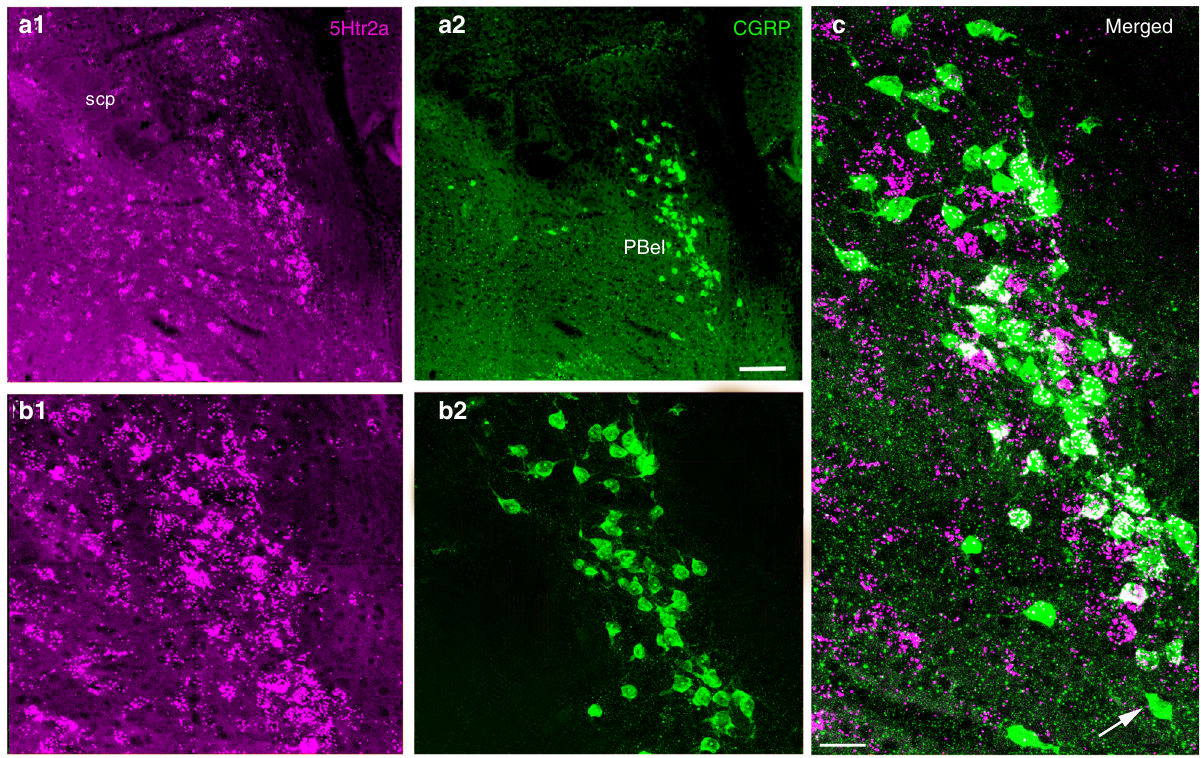
Fig. 7 Expression of 5HT 2a receptors mRNA (5Htr2a) by PBel CGRP neurons. Immuno fl uorescence photomicrographs of a brain section through the parabrachial area from a CGRP-L10-GFP mouse showing 5HT 2a receptor fl uorescence in situ hybridization in magenta ( a1 and b1 at low and higher mag) and CGRP neurons in green ( a2 , b2 ). The image is pseudo-colored in magenta-green to facilitate viewing by readers with color blindness. The merged image ( c ) shows that nearly all of the green CGRP neurons have some in situ hybridization grains (white) over their cell bodies (seen in n = 3). A lone exception is indicated by the white arrow. The scale bar represents 100 µ m in a1 and a2 ; 50 µ m in b1 and b2 ; and 20 µ m in c . scp, superior cerebellar